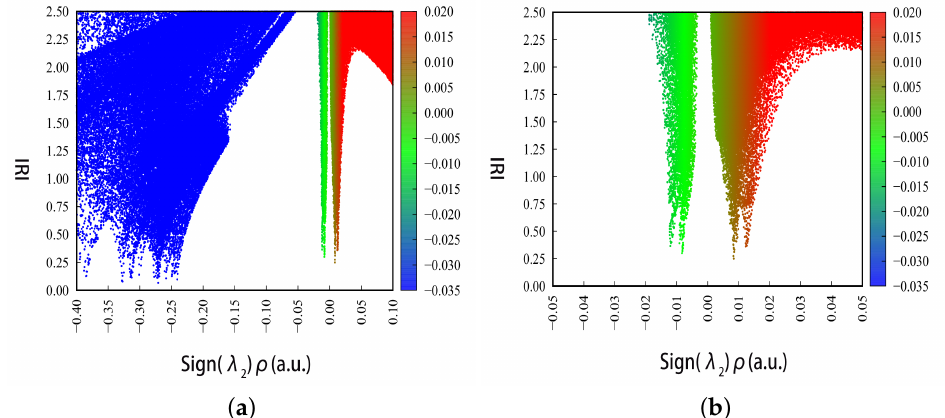
Figure 9. Color scatter maps of L-arginine. ( a ) Color scatter maps with sign( λ 2 ) ρ from − 0.40 to 0.10. ( b ) Color scatter maps with sign( λ 2 ) ρ from − 0.05 to 0.05.